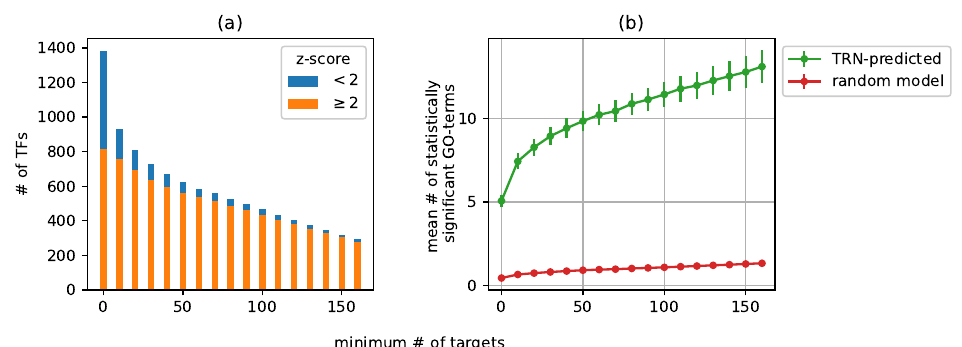
Figure 5. TRN-derived TF targets are enriched in a relatively higher number of GO terms. ( a ) Most of the transcription factors are enriched in more annotations compared to random target sets, and the percentage of highly annotated TFs grows with the minimum target count cutoff. ( b ) Shows a 95% confidence interval of the mean number of significant GO terms.